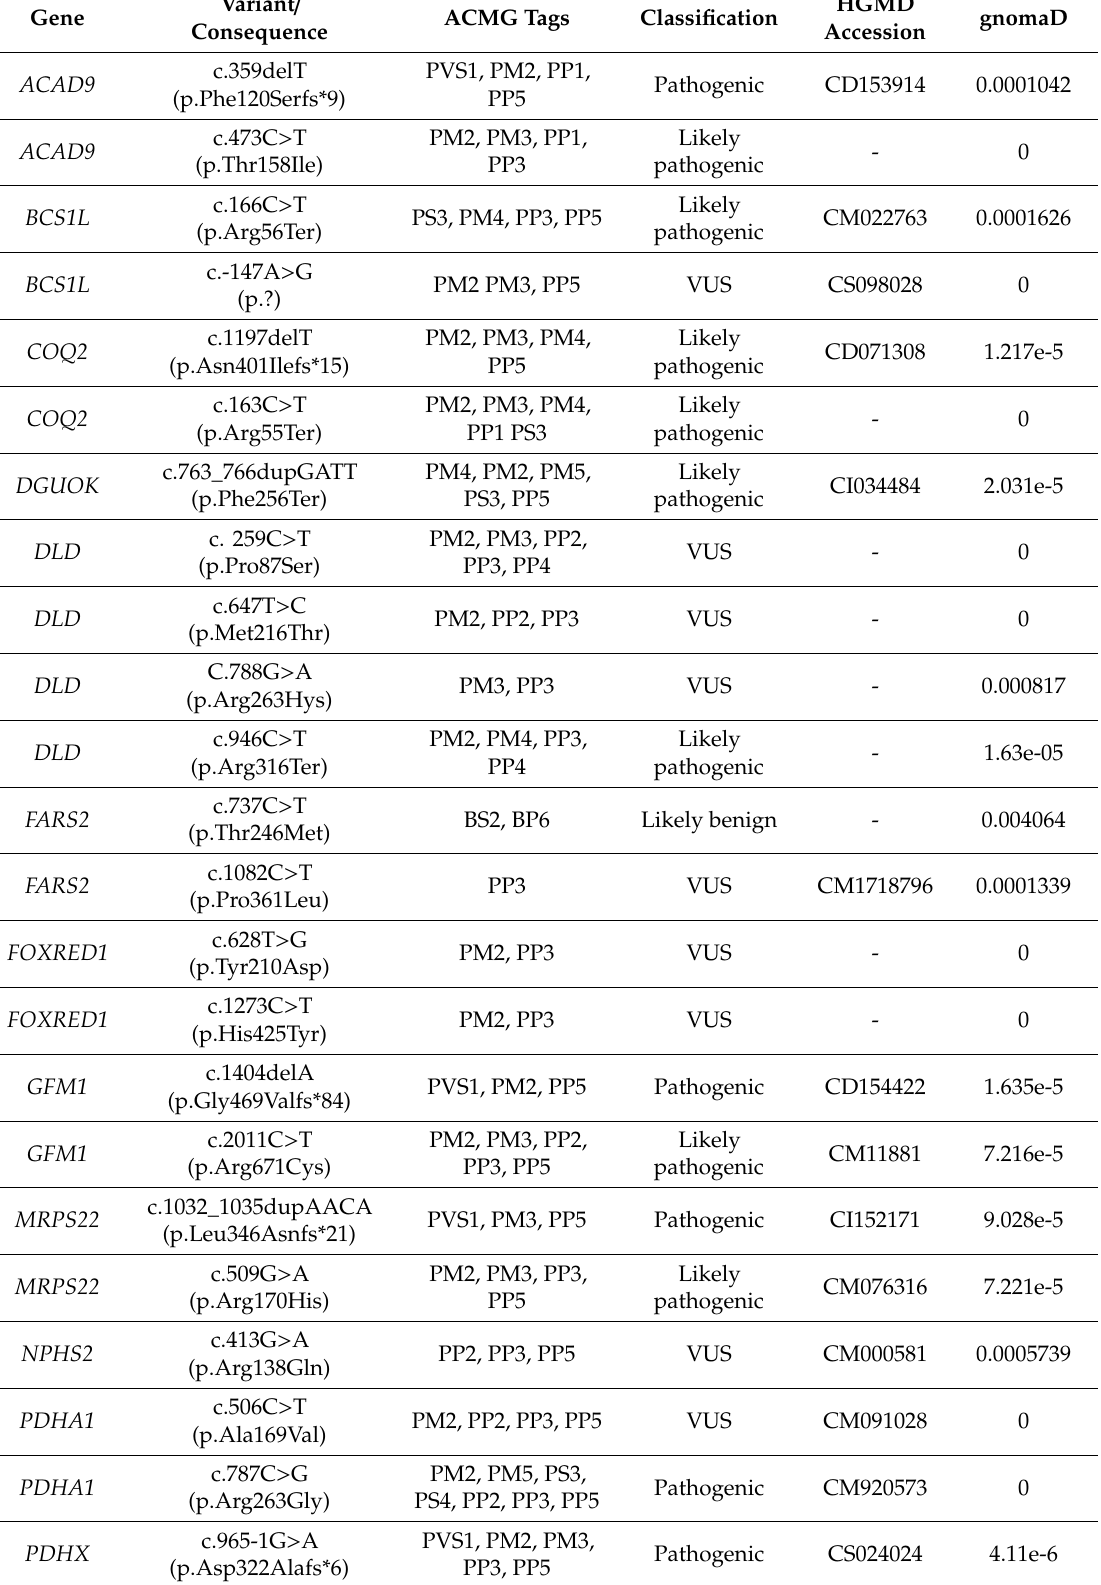
Table 2. Analysis of variants identified by massive-parallel sequencing and pathogenicity